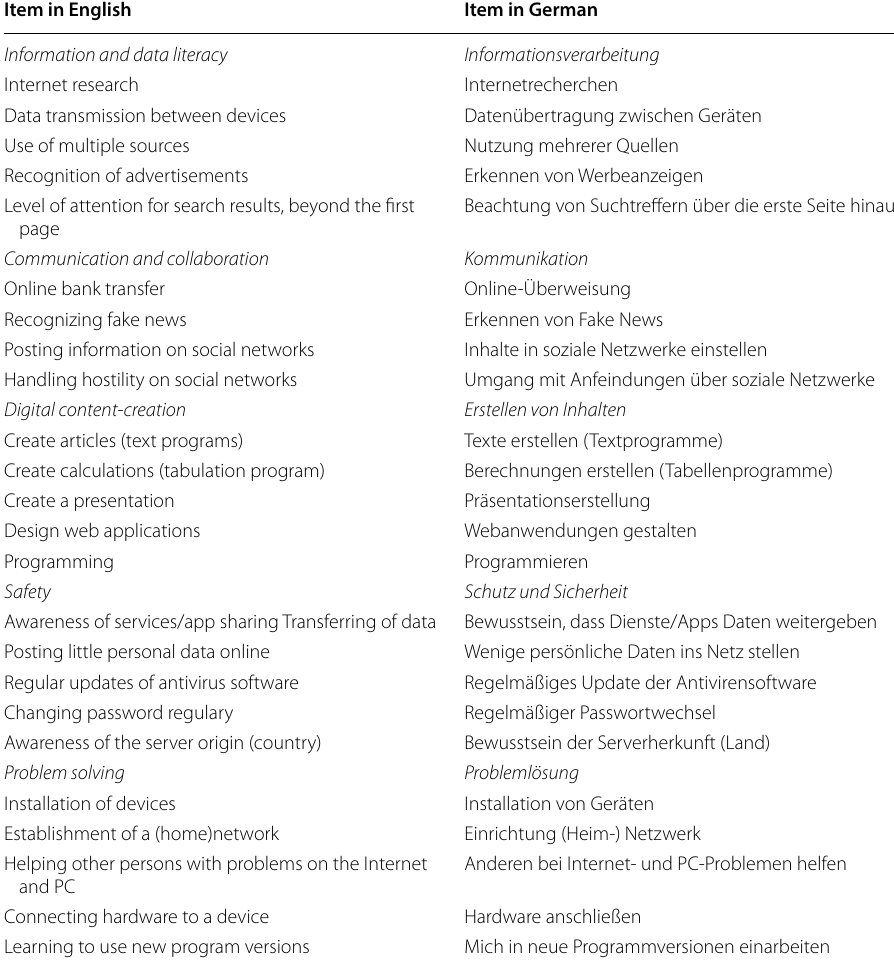
Table 2 Items and dimension in translation and in their original language Item in